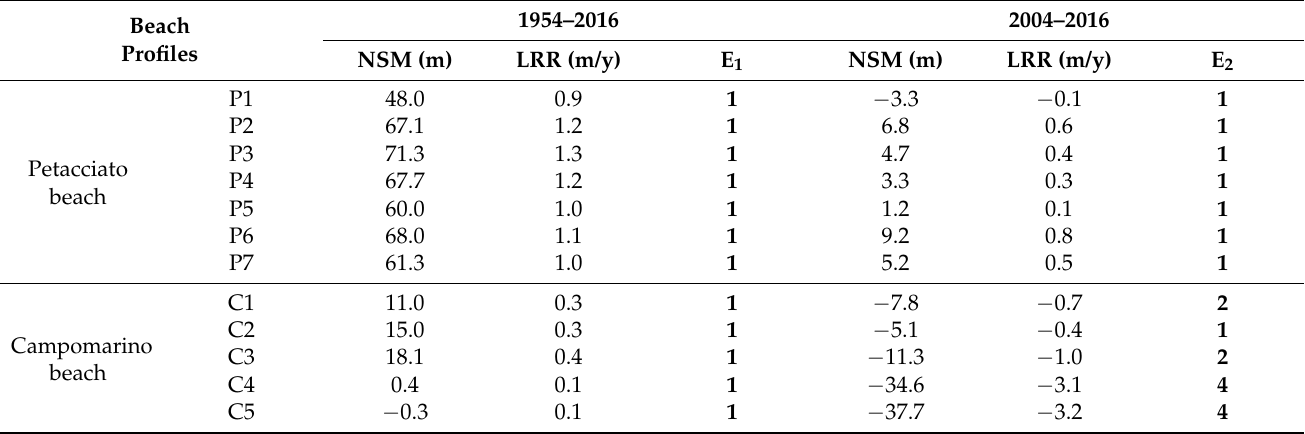
Figure 10. Annual shoreline change rates calculated for the beach profiles surveyed in the study areas for the periods 1954–2016, 2004–2016, 2016–2019, 2016–2020, and 2016–2021. Table 6. Shoreline changes in m (NSM) and annual shoreline change rates in m/y (LRR) calculated for the beach profiles in study areas A and B for the periods 1954–2016 and 2004–2016, and an evaluation of the related erosion indexes (E 1 and E 2